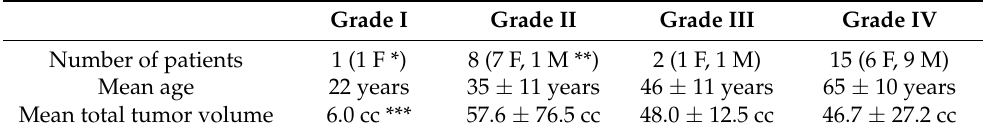
Table 1. Number of patients, mean total tumor volume, mean age, and sex across tumor grades. Note that edema was included in total volume, and the single grade I patient did not have much